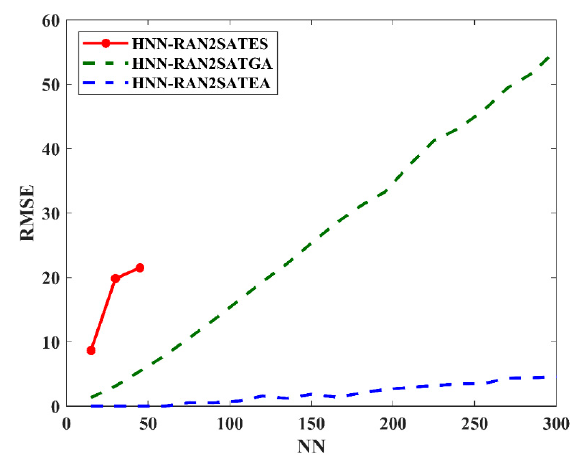
Figure 2. Root mean square error (RMSE) evaluation of various HNN-RAN2SAT models.